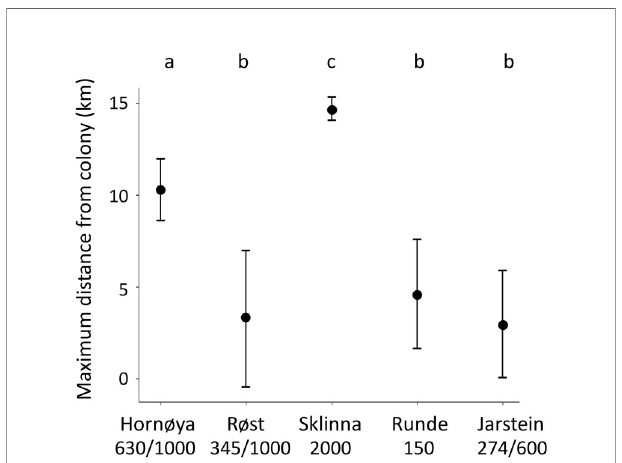
FIGURE 2 | Predicted values offoraging range between the fi ve study colonies based on the LMM results (mean ± CI). Only complete foraging trips were considered. Letters at the top correspond to the results of Tukey post-hoc tests based on the LMM (see Methods and Material ). Different letters indicate strong evidence for colony-speci fi c differences in foraging range (all z ≥ 3.4; P ≤ 0.005),same lettersindicate noevidence for such differences (allz ≤ 0.773, P ≥ 0.930). Colony sizes (number of breeding pairs) are given below the colony names. Numbers behind the dash (/) give the approximate total number of breeding pairs within the maximum foraging range of the focal colony, in case of neighbouring colonies.